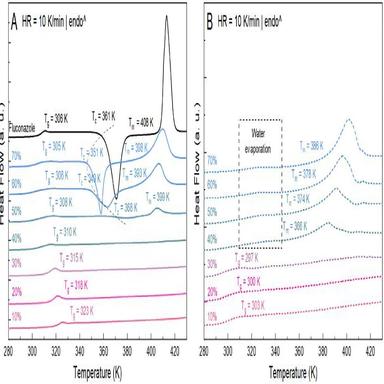
Thermograms of fresh (A) and aged (B) filaments with different fluconazole concentrations.